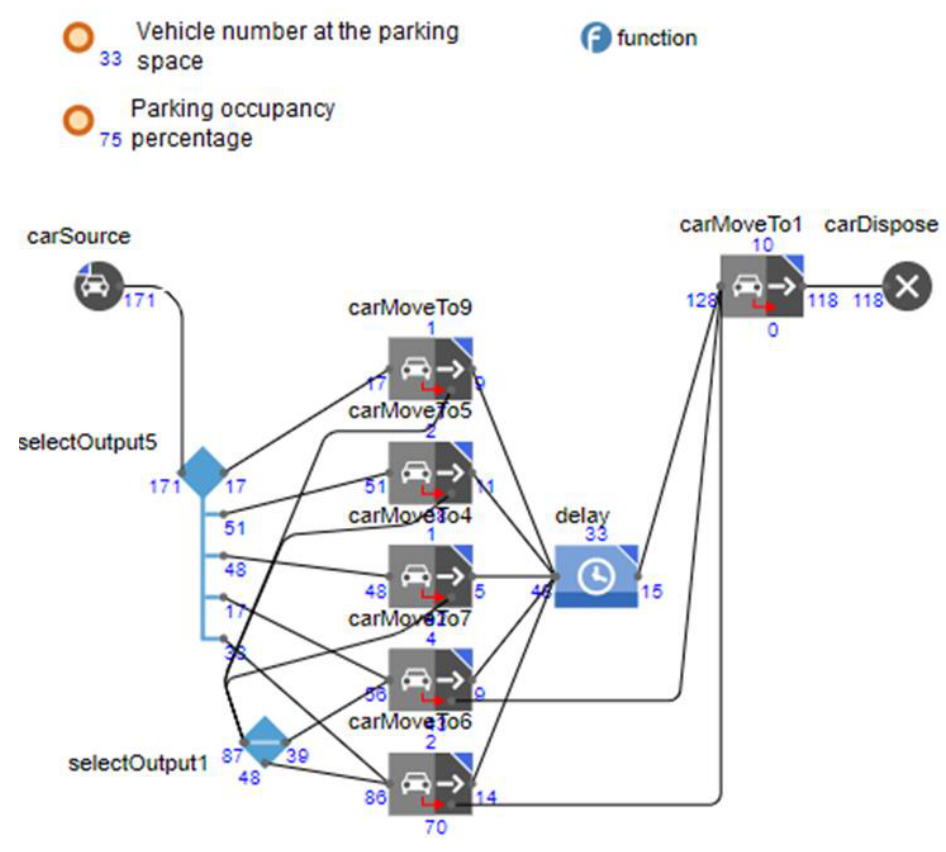
Figure 11. New simulation